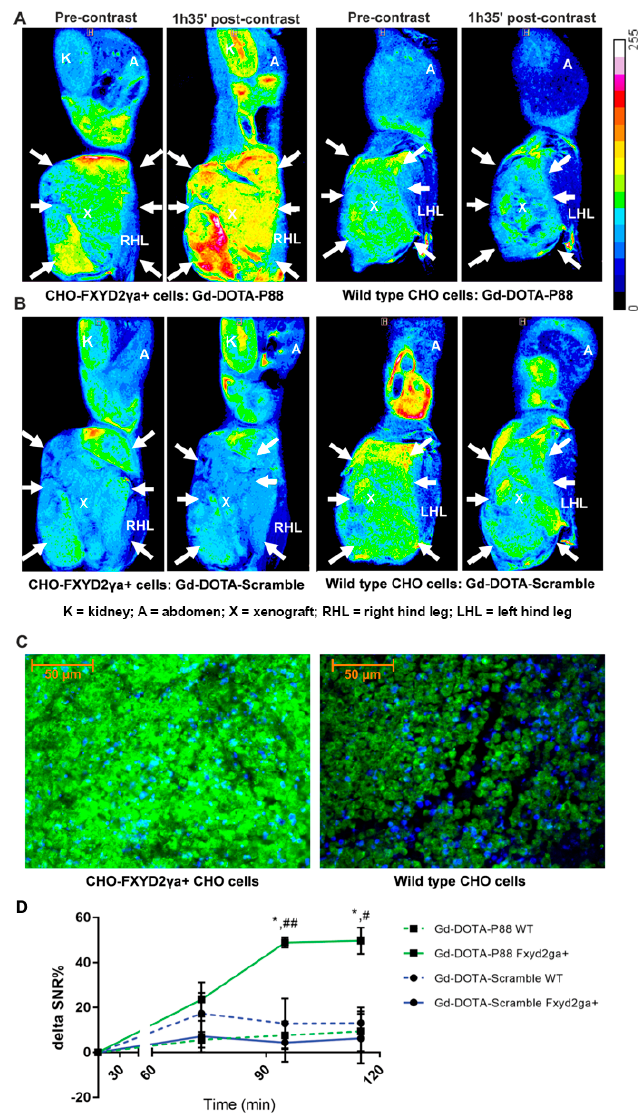
Figure 2. MR imaging of Gd-DOTA-P88 and Gd-DOTA-Scramble in mice implanted with CHO-FXYD2 γ a + and wildtype CHO cells. ( A , B ) Representative color overlay of MR images of mice bearing CHO FXYD2 γ a + or wildtype CHO xenografts. Pre-contrast images were acquired before the injection of CAs while the post-contrast images were obtained 95 min after i.v. administration of 0.1 mmoL Gd/kg b.w. of Gd-DOTA-P88 ( A ) or Gd-DOTA-Scramble ( B ). Mice were implanted with CHO-FXYD2 γ a + in the right hind leg and with wildtype CHO cells in the left hind leg (xenografts are indicated by arrows). The images are representative for images obtained in 3–4 mice. ( C ) The FXYD2 γ a expression in CHO-FXYD2 γ a + and wildtype CHO xenografts was confirmed by immunofluorescence, where the biomarker is stained in green with fluorescein and the nuclei are stained in blue with DAPI. ( D ) Region of Interest (ROI) quantification of the xenografts on the acquired images. The contrast enhancement is expressed as ∆ SNR%, Gd-DOTA-P88 is shown in green and Gd-DOTA-Scramble in blue; a solid line indicates CHO-FXYD2 γ a + while the dashed line indicates wildtype (wt) CHO cells. The data are expressed as means ± SD, n = 3–4 mice in each group; * p ≤ 0.05: Gd-DOTA-P88-FXYD2 γ a + vs. Gd-DOTA-P88-wt; # p ≤ 0.05, ## p ≤ 0.01: Gd-DOTA-P88-FXYD2 γ a + vs. Gd-DOTA-Scramble-FXYD2 γ a + ; Two-way ANOVA with Š í d á k correction for multiple tests. Legend: K = kidney; A = abdomen; X = xenograft; RHL = right hind leg; LHL = left hind